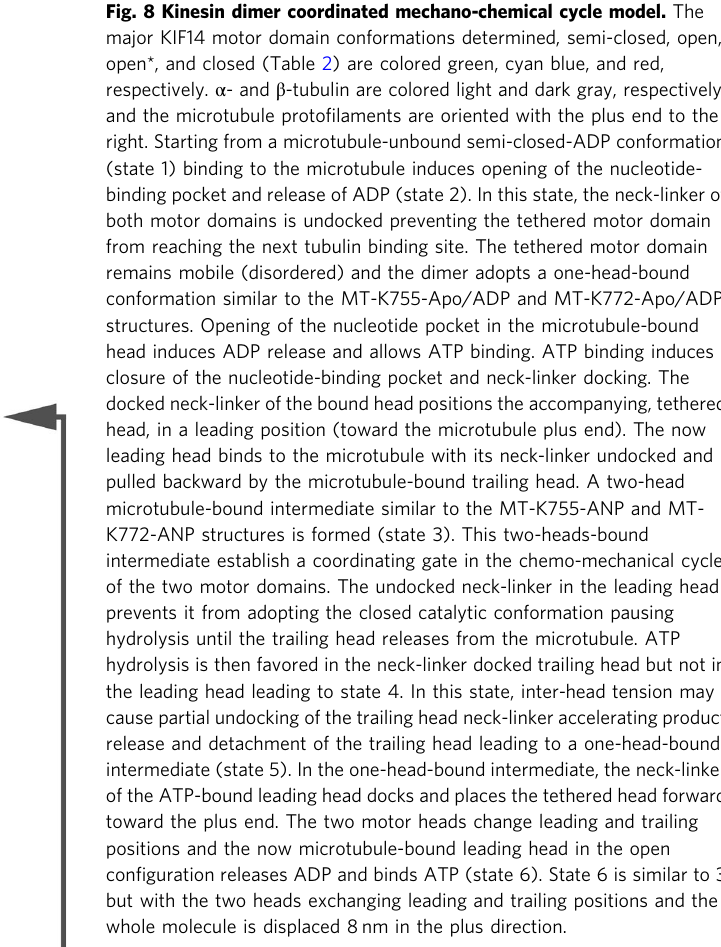
Fig. 8 Kinesin dimer coordinated mechano-chemical cycle model. The major KIF14 motor domain conformations determined, semi-closed, open, open*, and closed (Table 2) are colored green, cyan blue, and red, respectively. α - and β -tubulin are colored light and dark gray, respectively, and the microtubule proto fi laments are oriented with the plus end to the right. Starting from a microtubule-unbound semi-closed-ADP conformation (state 1) binding to the microtubule induces opening of the